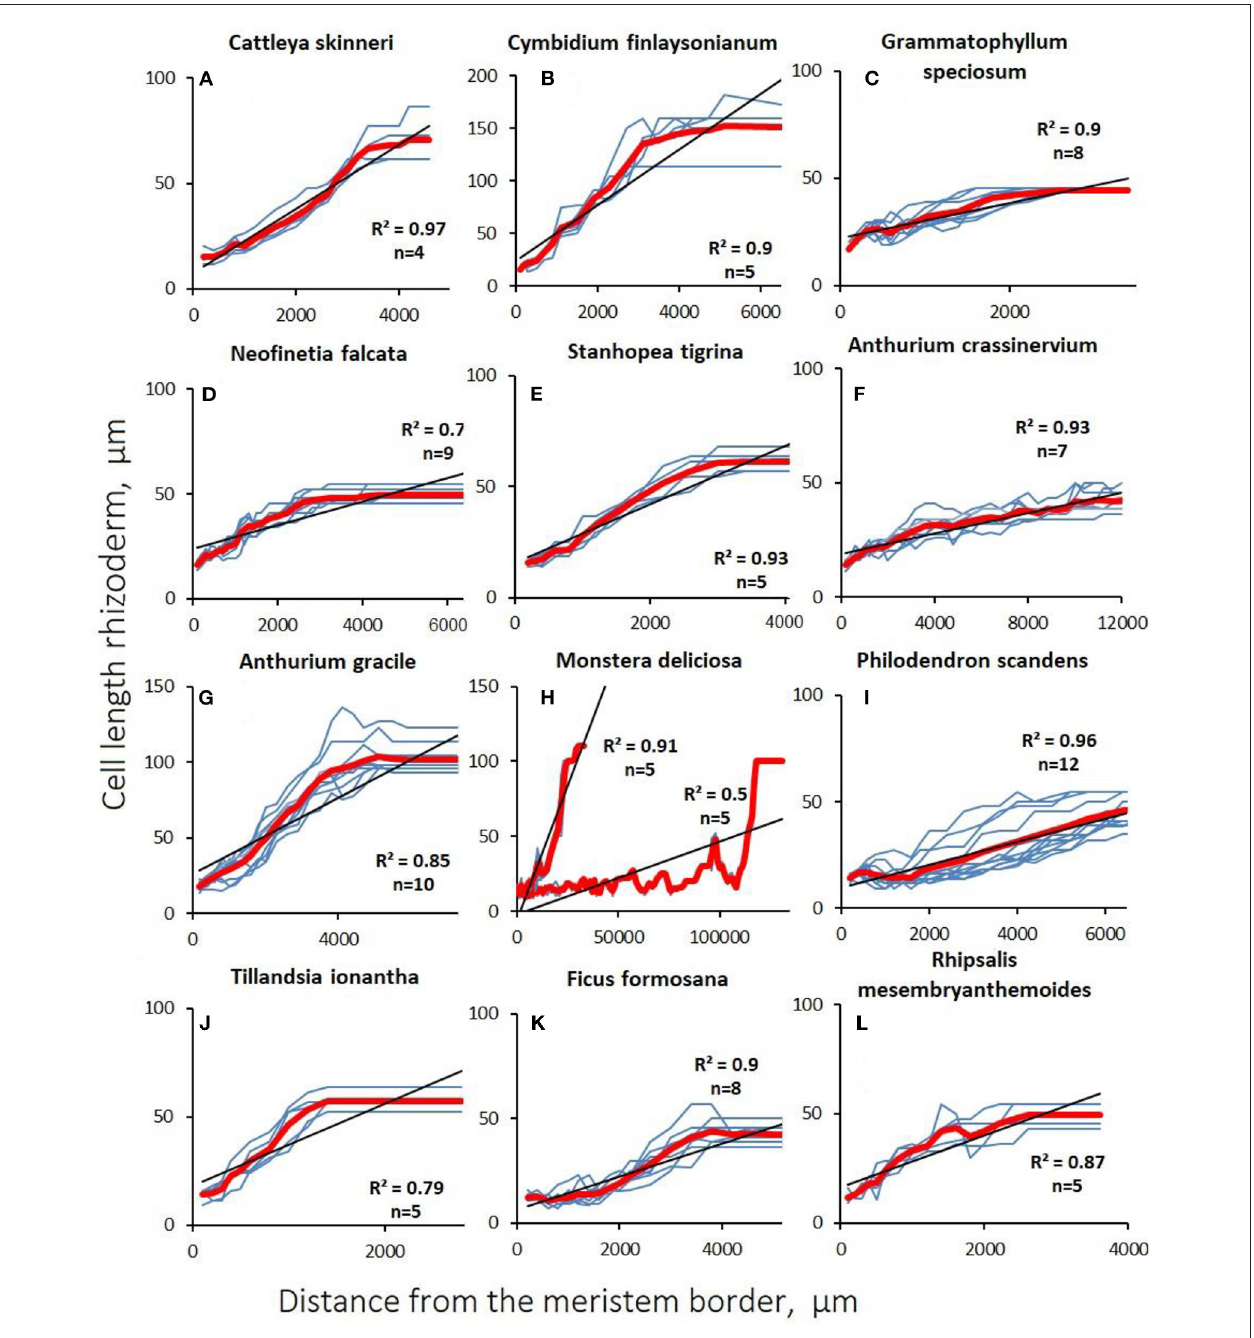
FIGURE 5 | Changes in rhizodermal cell length with distance from the apex (distal apical meristem border) of aerial roots. Gray lines are data for a single studied root section of the root. The red line is the average value. The coefficient of determination are given to the average value, ( n ) is the number of sections examined. (A–E) Orchidaceae; (F–I) Araceae; (J) Bromeliaceae; (K) Moraceae; (L) Cactaceae.